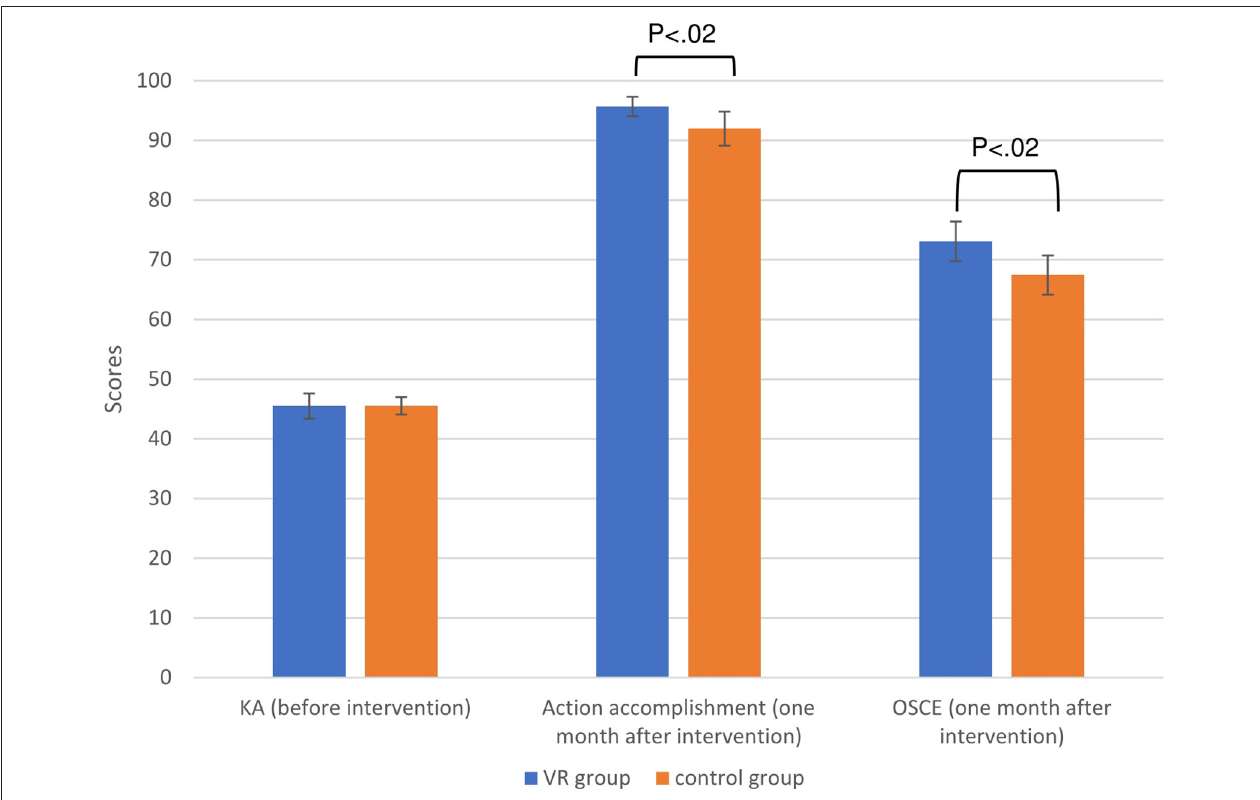
FIGURE 3 | Knowledge and Attitude of Chemotherapy Administration before intervention (maximum score 50), Checklist of Action Accomplishment after intervention (maximum score 100), and OSCE score (maximum score 100) after intervention among the participants ( N = 83). Error bars = 95 % confidence interval. KA, Knowledge and Attitude; OSCE, Objective Structured Clinical Examination score; VR, virtual